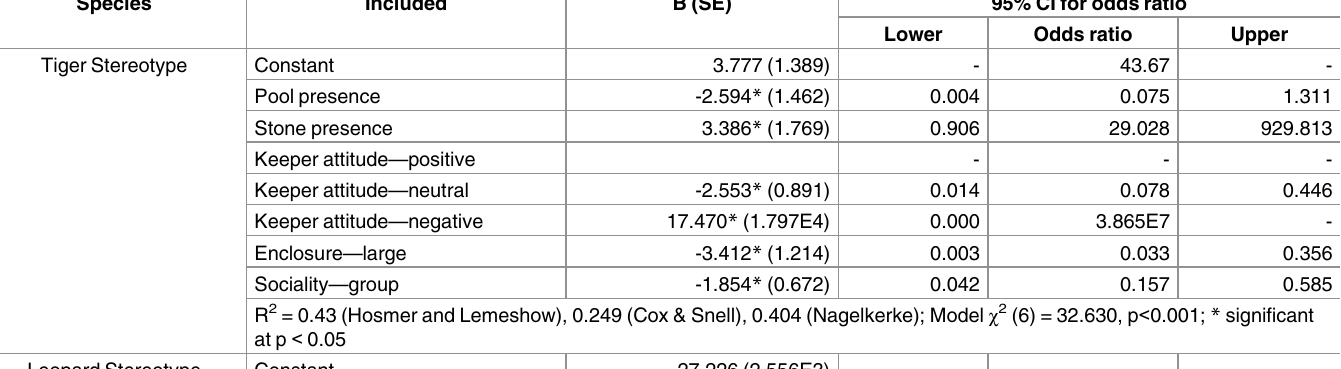
Table 5. Binary logistic regression equation employed to predict the outcome of stereotypic behaviour (0 = absence and 1 presence)and FCM lev- els (0 = low and 1 high) in tigers and leopards using the biological and environmental variables.